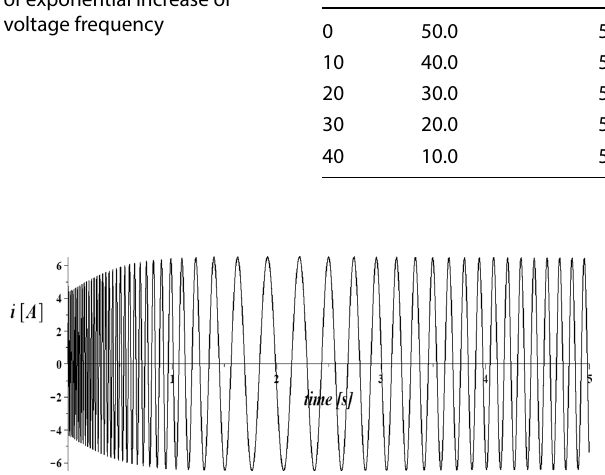
Table 2 Characteristics of current frequency in the case of exponential increase of voltage frequency